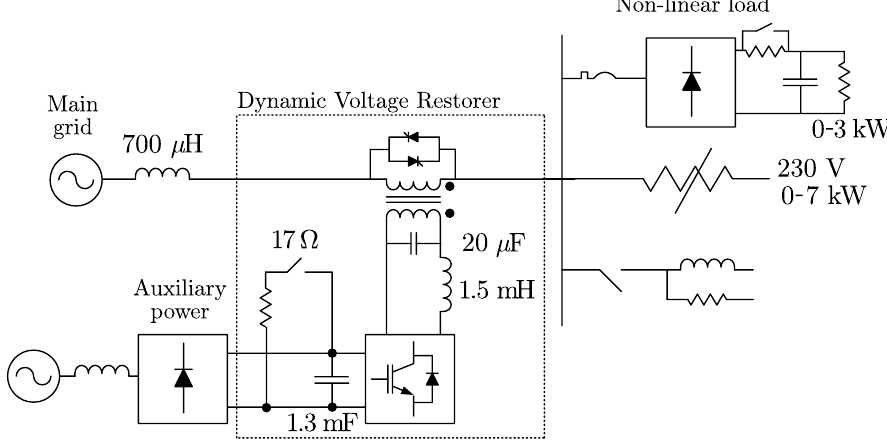
Figure 7. Schematics of the prototype. The power can be taken from an auxiliary electrical network, the grid-side of the DVR, or the load-side of the